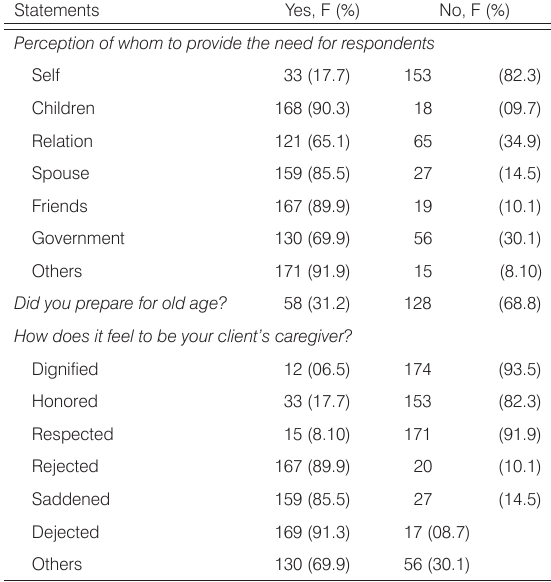
Table 3. Percentage distribution on the perceptions of the provision of existing caregivers ( n =